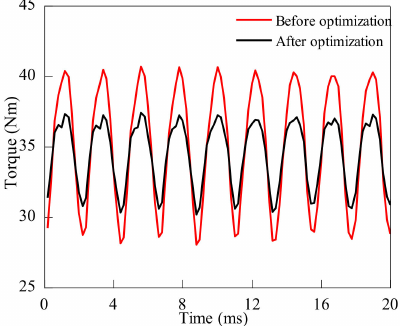
Figure 17. Comparison of output torque before and after